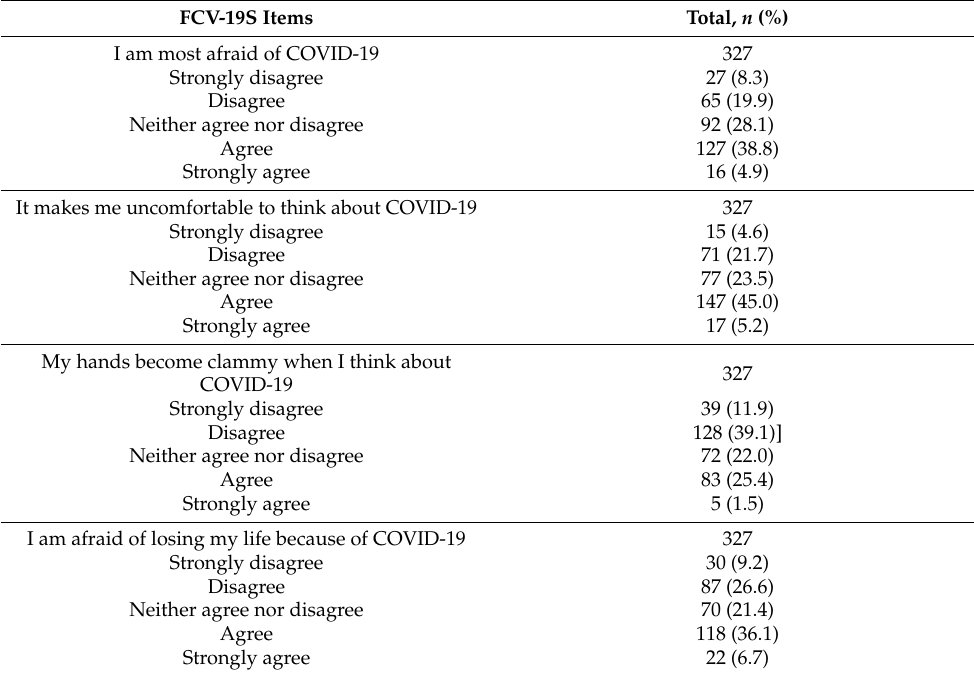
Table 3. Level of fear of COVID-19 among the study